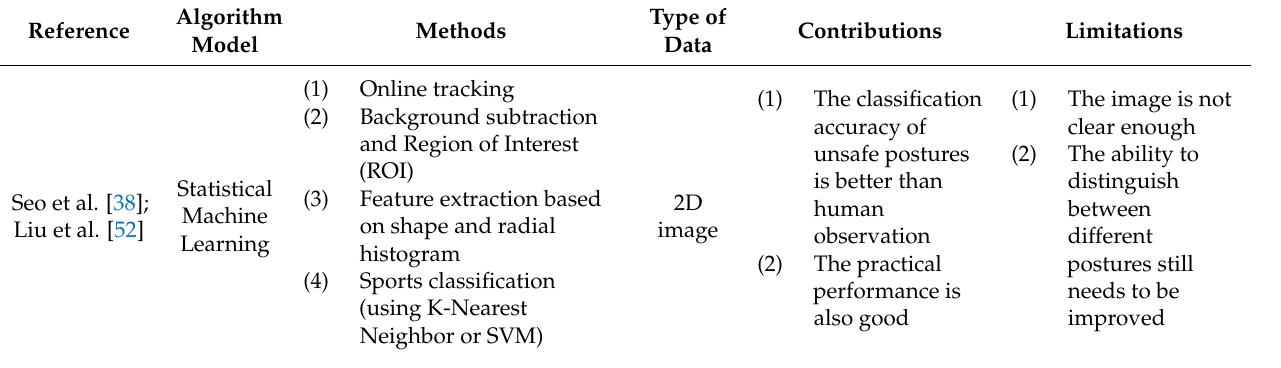
Table 2. Research details of behavior recognition.